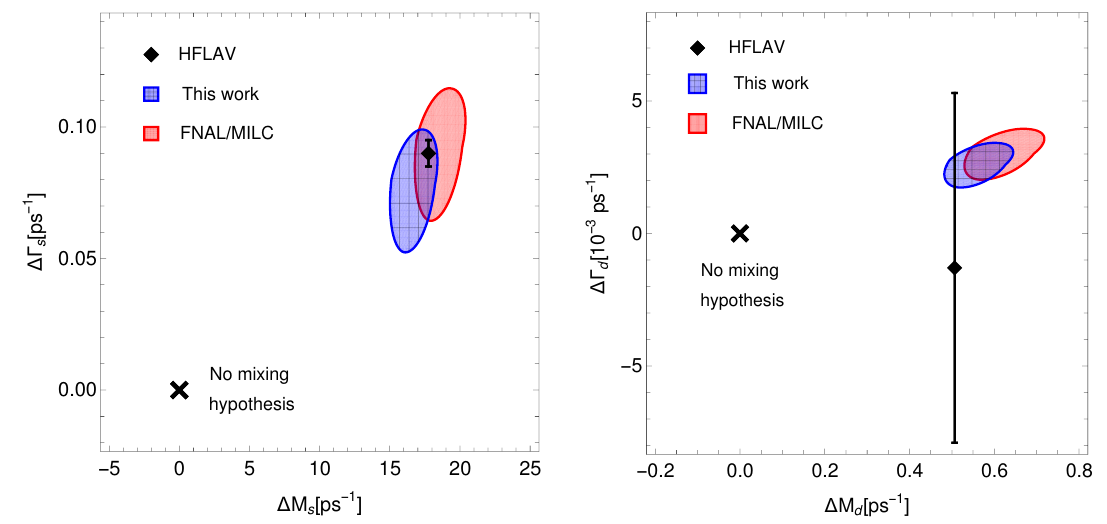
Figure 8 . Comparison of our predictions for the mass and decay rate di(cid:11)erence in the B s (left) and B d (right) system with the present experimental averages (error bars). We also show the results obtained with the lattice results of [5] for f 2 B Q and the matrix element h R 0 i and the values given B q i in appendix B for the other input parameters. The PS mass scheme for the bottom quarks has been used in both cases.